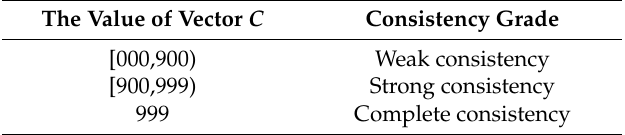
Table 4. Corresponding relationship between the value range of vector C and consistency